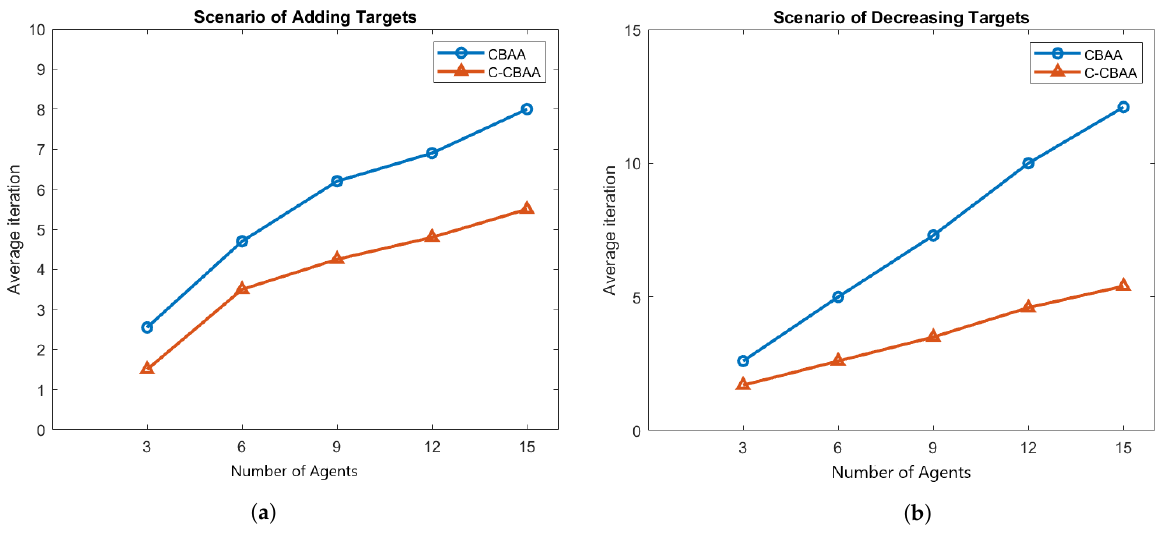
Figure 9. Compare the performance of two algorithms. ( a ) Increasing targets. ( b ) Decreasing